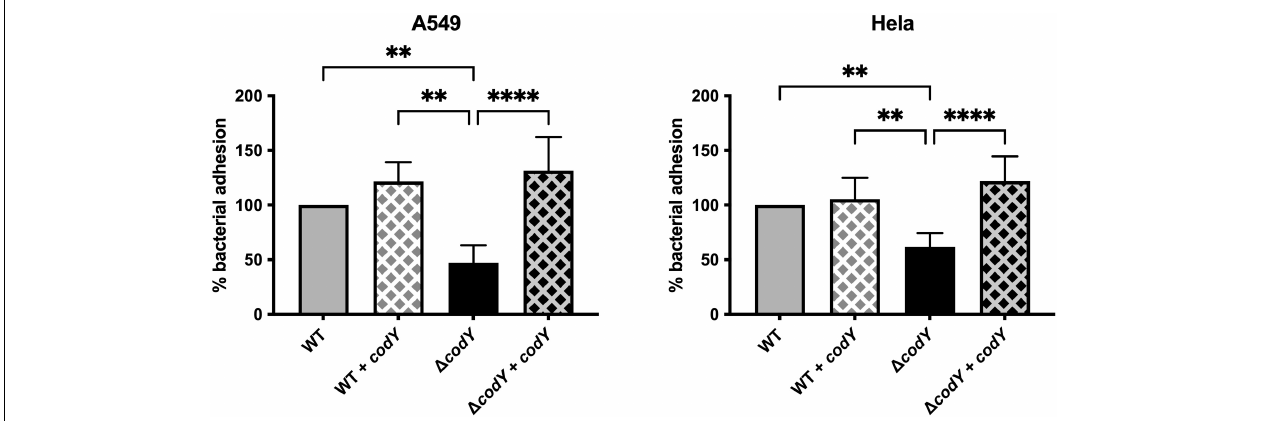
FIGURE 3 | CodY controls GBS adhesion to epithelial cells. Cell adhesion was quantified using HeLa and A549 immortalized cell lines. The WT and the (cid:49) codY mutant contain the empty vector pTCV (cid:127) P tet or the complementing vector pTCV (cid:127) P tet _ codY (+ codY ). The percent of adhesion of each strain was calculated relative to the initial inoculum and was normalized to the adhesion of the WT strain, set as 100%. Represented data are the average ± SD of six independent experiments, each performed in duplicate. Statistically significant differences are indicated (One-way ANOVA). ∗∗ p < 0.01, ∗∗∗∗ p < 0.0001.